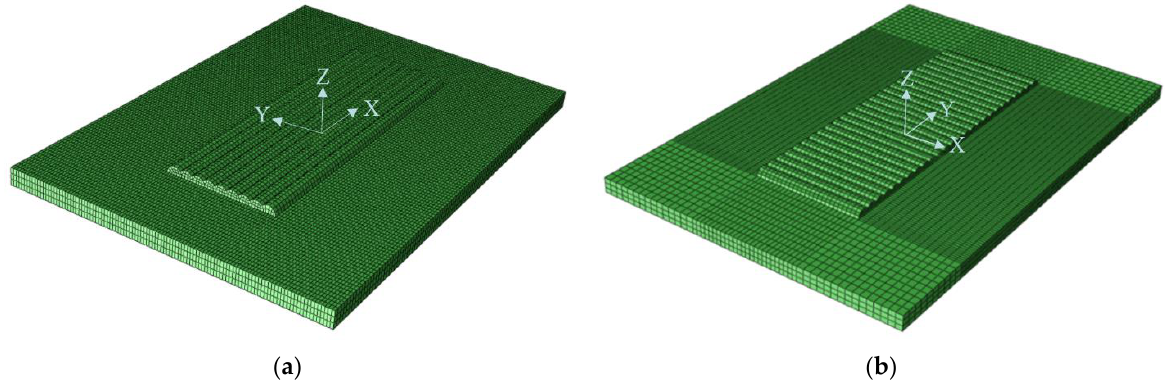
Figure 1. Finite element model: ( a ) Long-edge scanning; ( b ) Short-edge scanning.